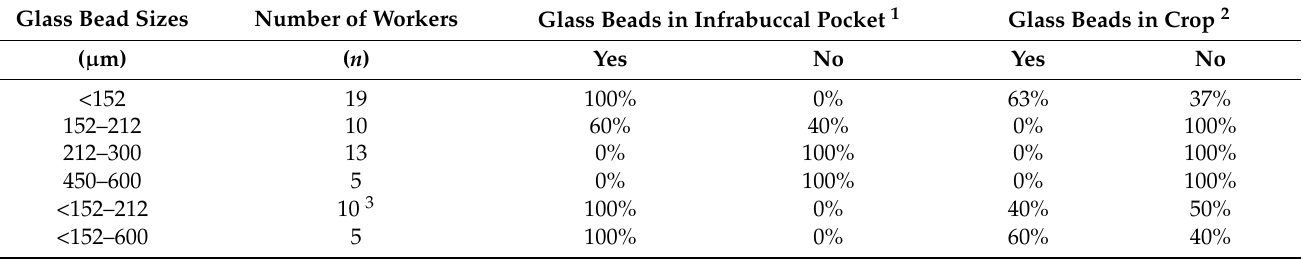
1 Results of χ 2 contingency table for glass beads in infrabuccal pocket: χ 2 (5) = 51.516, p < 0.001, ϕ c ≈ 0.912. 2 Results of χ 2 contingency table for glass beads in crop: χ 2 (5) = 24.428, p < 0.001, ϕ c ≈ 0.633. 3 The abdomen of one individual was not